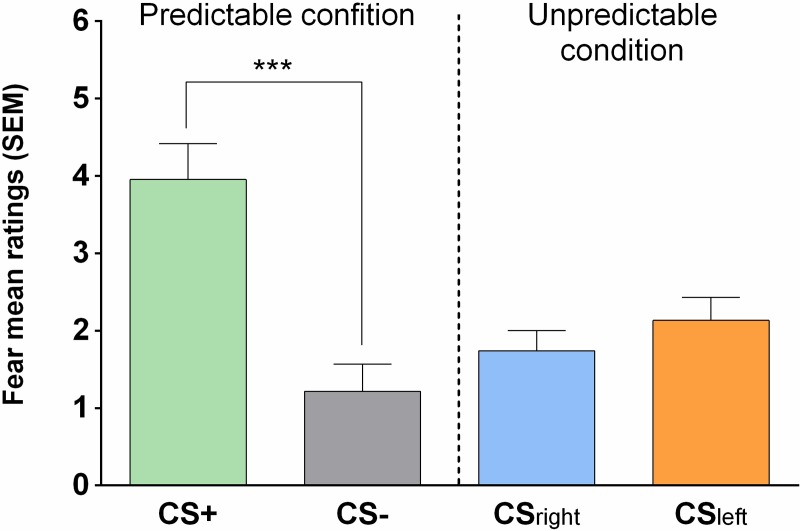
Fear ratings associated with the type of movement.In the PC, the level of fear was the highest for the movement associated with pain application (CS+) compared to the movement never associated with pain application (CS-). In the UC, no difference was found for fear level associated with the CSright and CSleft movements.